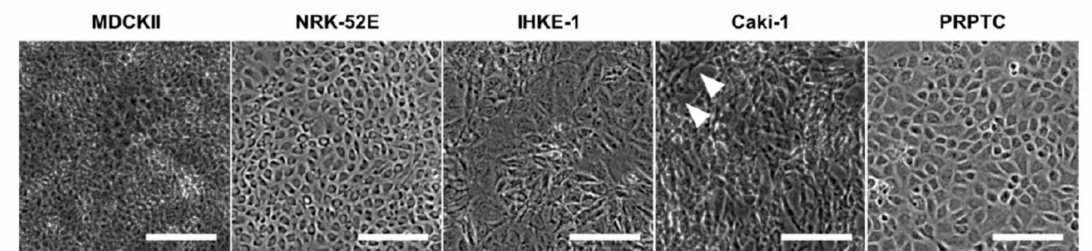
Figure 2. Phase contrast images of the renal cell lines MDCKII, NRK-52E, IHKE-1 and Caki-1, and of cultured PRPTCs. All cells were cultured on chambered glass slides for 5 days under standard conditions. Under these conditions, MDCKII, NRK-52E, IHKE-1 and PRPTC cells formed a confluent monolayer. In contrast, Caki-1 cells did not form a confluent monolayer and cell-free gaps (white triangles) remained even after extended culture periods. Scale bars = 200 µ